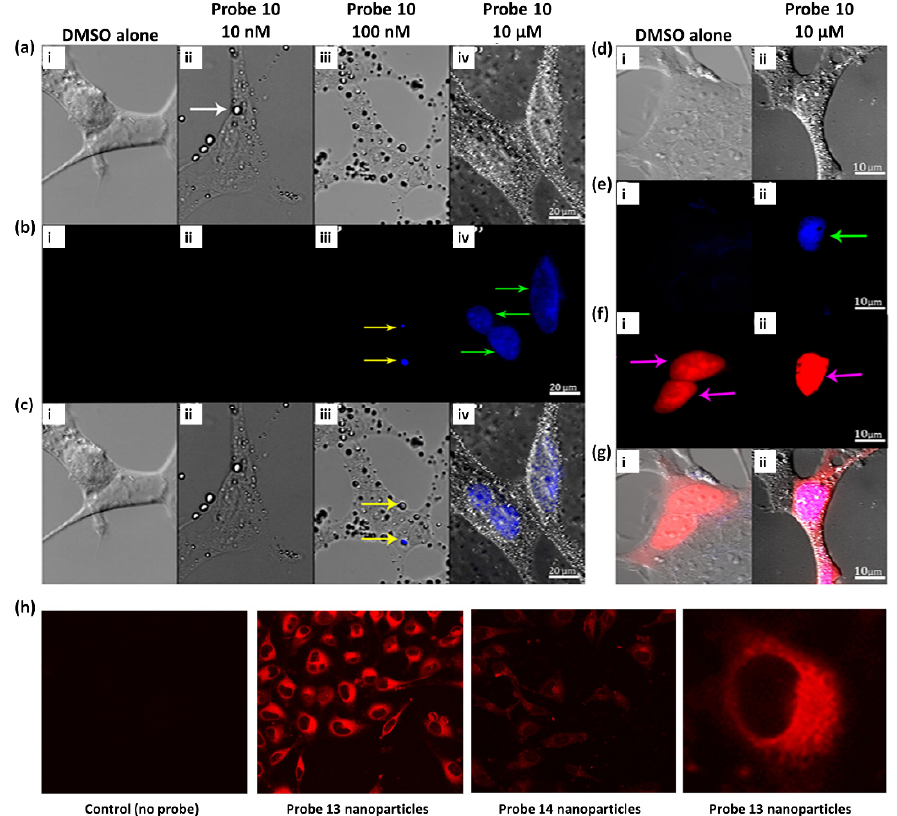
Figure 7. ( a – c ) Probe 10 fluorescently labels the nuclei of cells. HEK293 cells were imaged 5 min post-treatment in ( a -i, b -i, c -i) 1% DMSO cell media, ( a -ii, b -ii, c -ii) 1% DMSO and 10 nM probe 10 cell media, ( a -iii, b -iii, c -iii) 1% DMSO and 100 nM probe 10 cell media, or ( a -iv, b -iv, c -iv) 1% DMSO and 10 µ M probe 10 cell media. ( a -i, ii, iii, iv) Bright-field images. ( b -i, ii, iii, iv) A 380 nm excitation channel and 450 nm emission fluorescence channel to image probe 10 . ( c -i, ii, iii, iv) Merged images of bright-field and fluorescent images. Spherules (white arrows) are seen to form on the cell membranes at all concentrations tested of probe 10 (10 nM, 100 nM, and 10 µ M) but fail to be observed when only DMSO was present. Several of these spherules produce significant amounts of blue fluorescence (yellow arrows), indicating the presence of probe 10 . The nuclei (green arrows) can be visualized following 10 µ M treatment with probe 10 . ( d – g ) Validation of probe 10 for nuclear staining. HeLA cells were transfected with an mScarlet-NLS expression construct and imaged 5 min post-treatment in ( d -i, e -i, f -i, g -i) 1% DMSO cell media or ( d -ii, e -ii, f -ii, g -ii) 1% DMSO and 10 µ M probe 10 media. ( d -i, d -ii) Bright-field image. ( e -i, e -ii) A 380 nm excitation channel and 450 nm emission fluorescence channel to image probe 10 . ( f -i, f -ii) A 570 nm excitation channel and 600 nm emission fluorescence channel to image mScarlet-NLS. ( g -i, g -ii) Merged images of all channels in the treatment condition. The nuclei (green arrows) can be visualized following 10 µ M treatment, which overlaps with fluorescence being emitted from nuclei indicated by mScarlet-NLS (magenta arrows). Reprinted with permission from Ref. [105]. Copyright 2020, American Chemical Society. ( h ) Fluorescence signal of probe 13 and 14 nanoparticles in cells. HeLa cells grown on glass coverslips were incubated for 20 h with no nanoparticles (medium alone), probe 13 nanoparticles, or probe 14 nanoparticles and analyzed by fluorescence confocal microscopy with the same instrumental setting for comparison. Representative images are shown. In the case of probe 13 nanoparticles, cell signal distribution details are shown at higher magnification. Reprinted with permission from Ref.